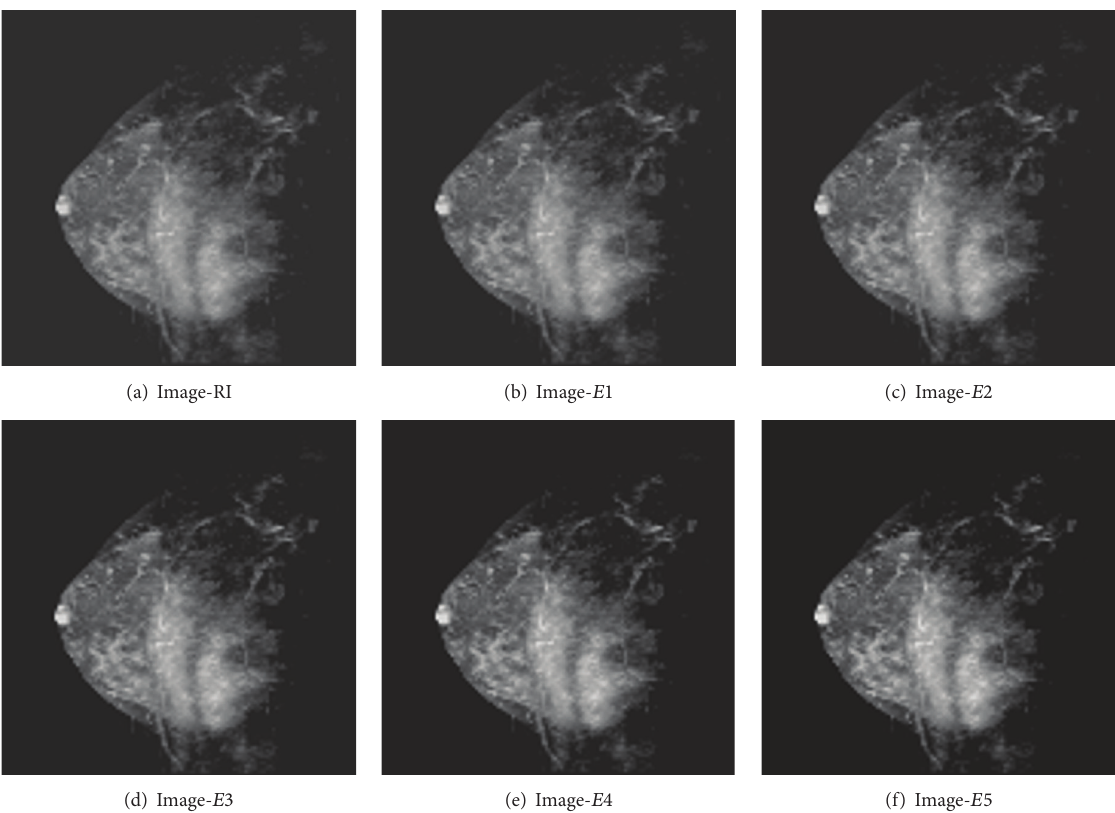
Figure 3: Different versions of one breast cancer image.